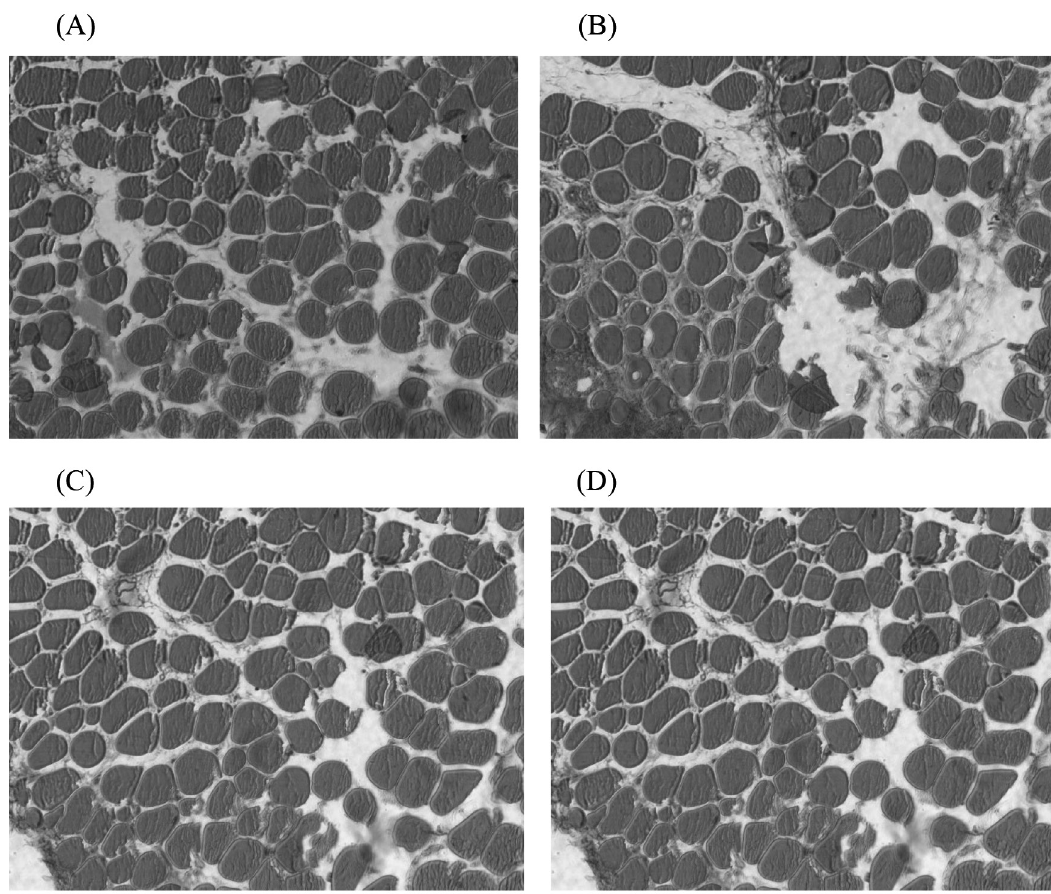
Figure 5. The paraffin sections of breast muscle fiber in the 49th day offspring in 400× AMG EVOS microscope. (A) 100% energy group; (B) 80% energy group; (C) 70% energy group; (D) 50% energy group. Breast muscles were dehydrated in alcohol and finally embedded in paraffin wax. Transverse sections 10 mm thick were cut, stained with haematoxylin and eosin, and mounted in the usual way. Subsequently, 8 photomicro- graphs for fibre diameter measurements were taken using the AMG EVOS microscope's particular morphometric function. In each muscle sam - ple, more than fifty diameters were measured, and the densities were calculated. On the 49th days, the diameter and density of breast muscle fi - bres in the offspring in the 80% energy group were not significantly different from those in the 100% energy group, indicating that there was a compensatory effect on muscle fibre growth, the breast muscle fibre density in the 70% and 50% energy groups was significantly increased or showed an increasing